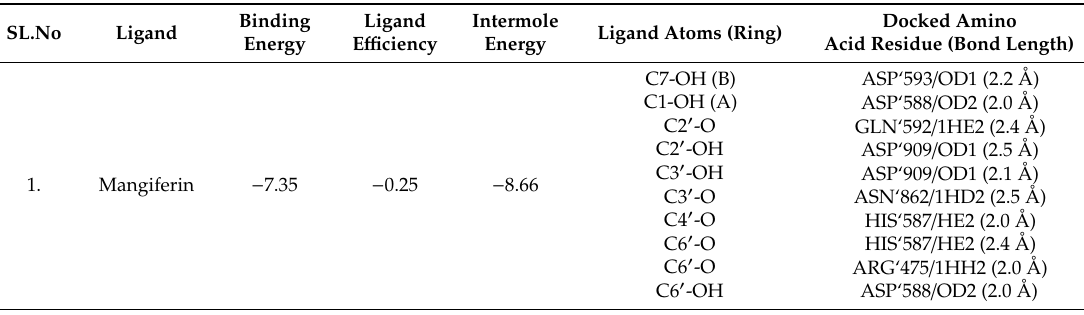
Table 2. Hydrogen bond interaction of mangiferin and amino acid residues of S. mutans glucansucrase.